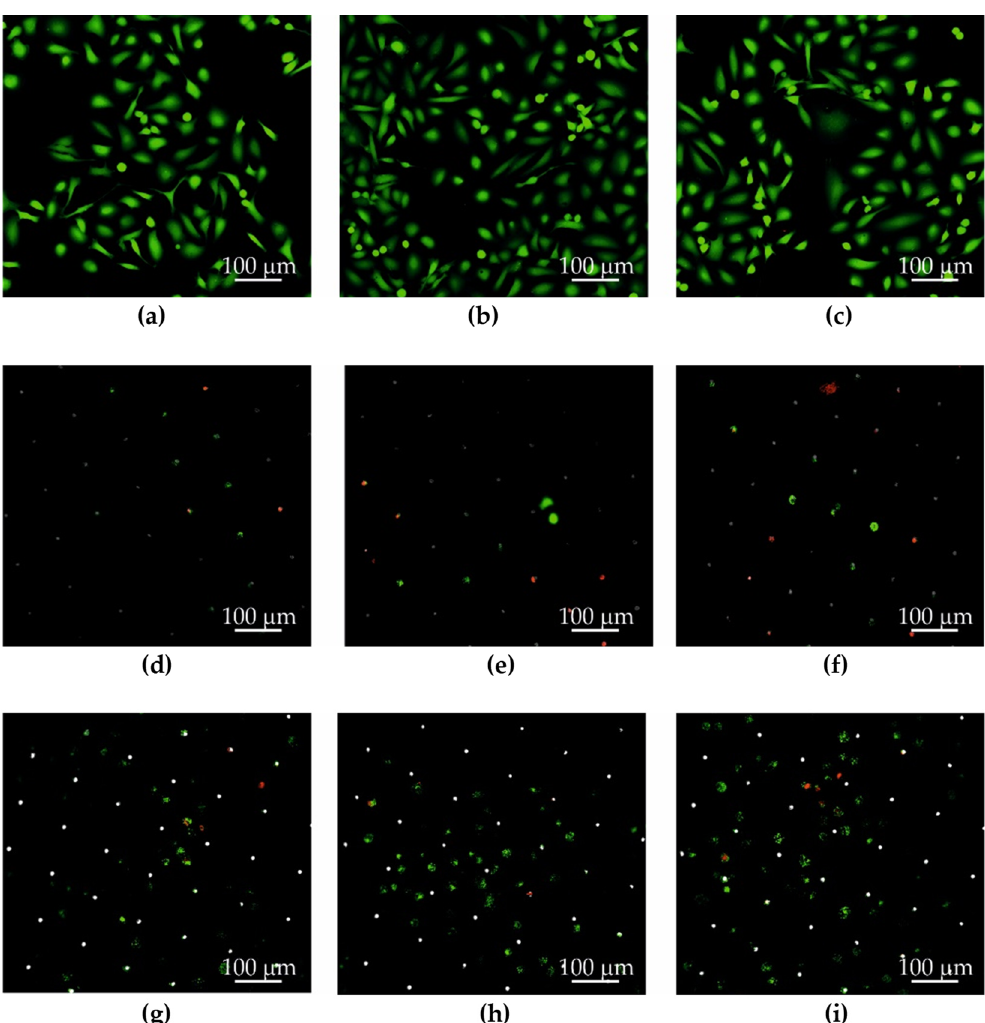
Figure 7. DU 145 cancer cells: culture on a Petri dish ( a – c ), on a Ni microsieve ( d – f ), and a Ni + GO sieve ( g – i ). The LIVE/DEAD™ Viability/Cytotoxicity Kit was used for staining (cells stained green— living cells, cells stained red—dead cells).